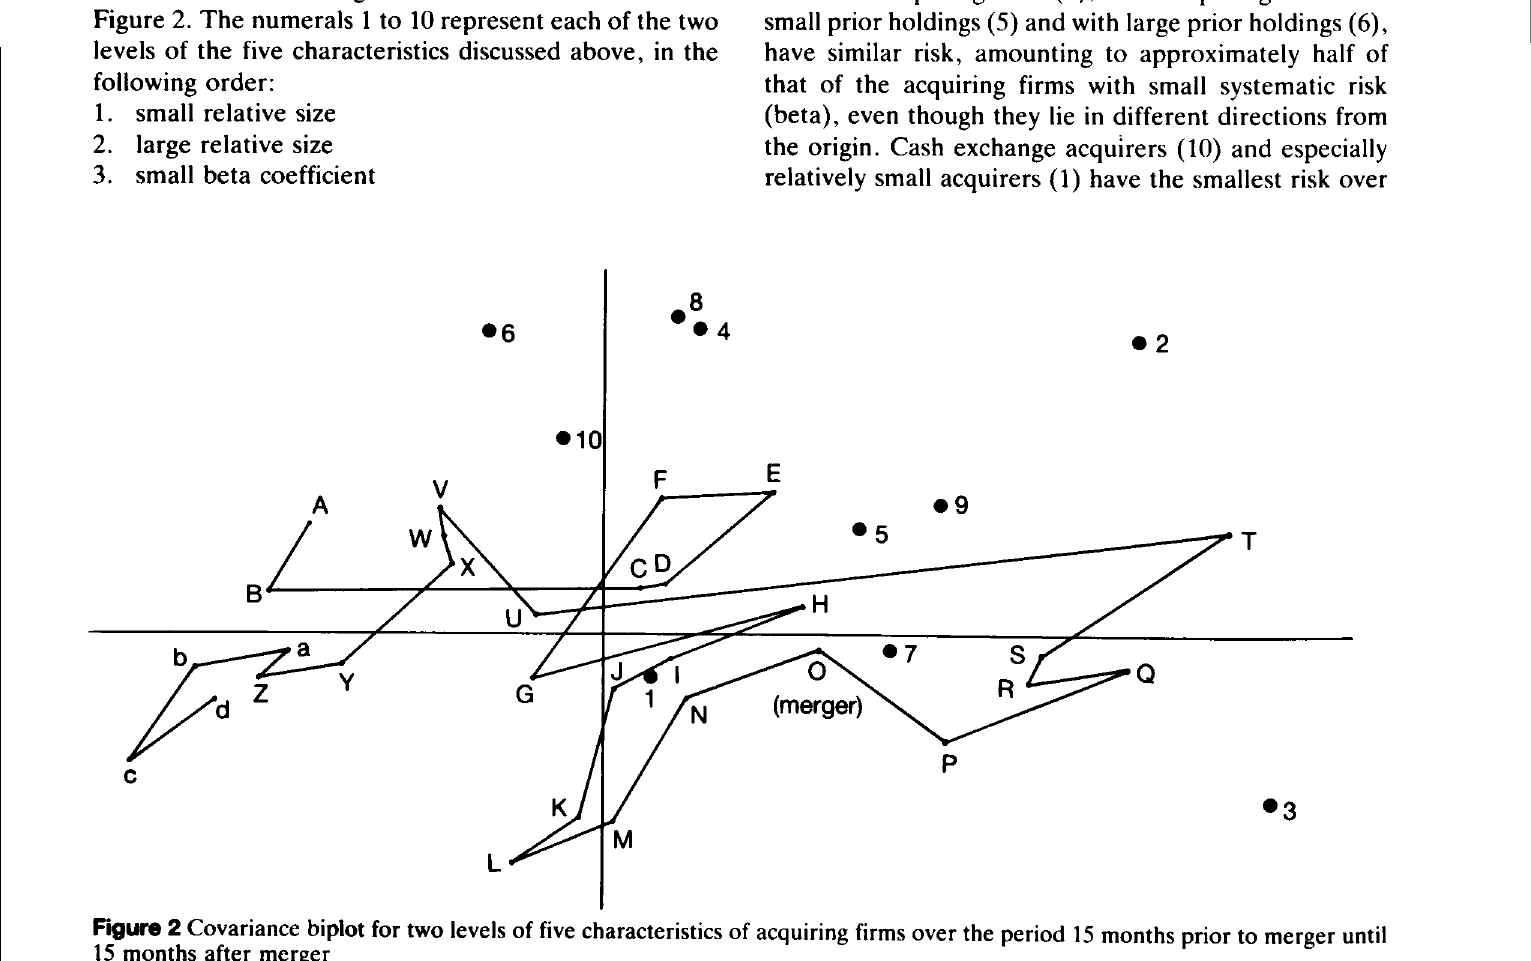
Figure 2 Covariance biplot for two levels of five characteristics of acquiring firms over the period 15 months prior to merger until 15 months after